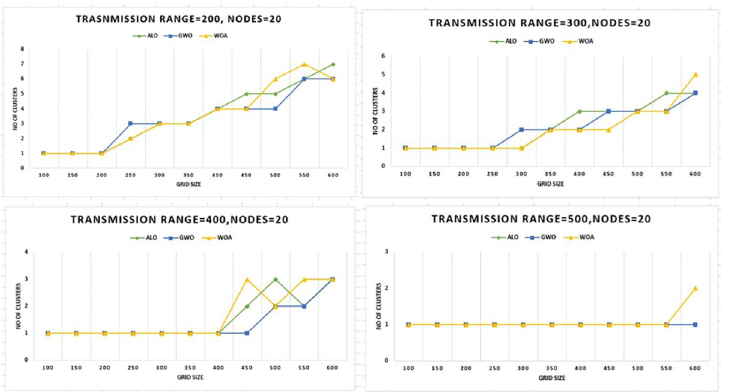
Fig 14. Grid size versus number of clusters for 20